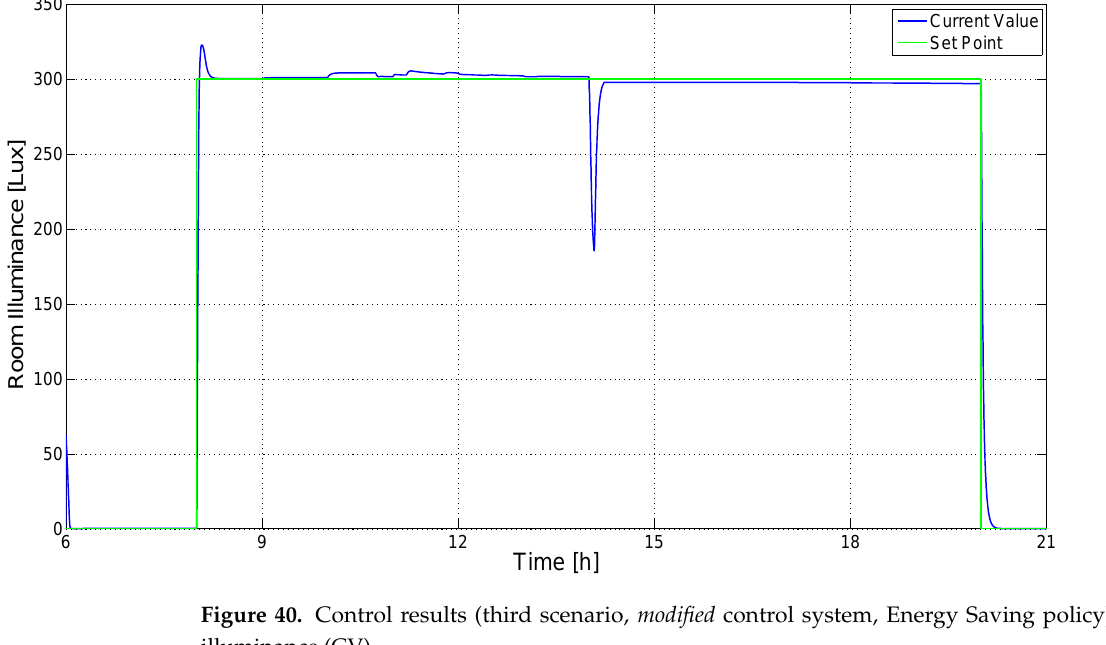
Figure 39. Control results (third scenario, modified control system, Energy Saving policy): room tem- perature (CV), outside temperature, and solar radiation (DVs).